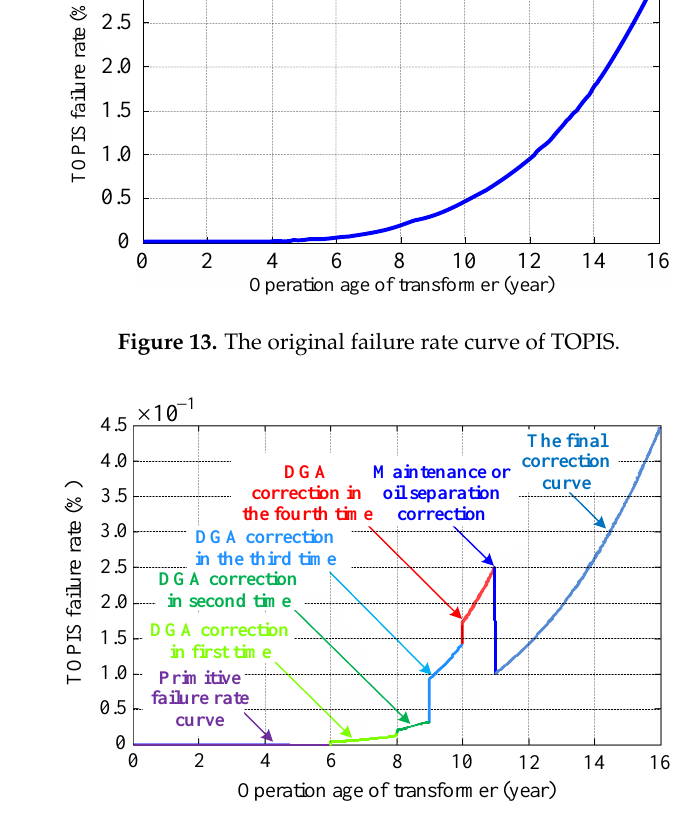
Figure 14. Actual failure rate curve of the TOPIS.